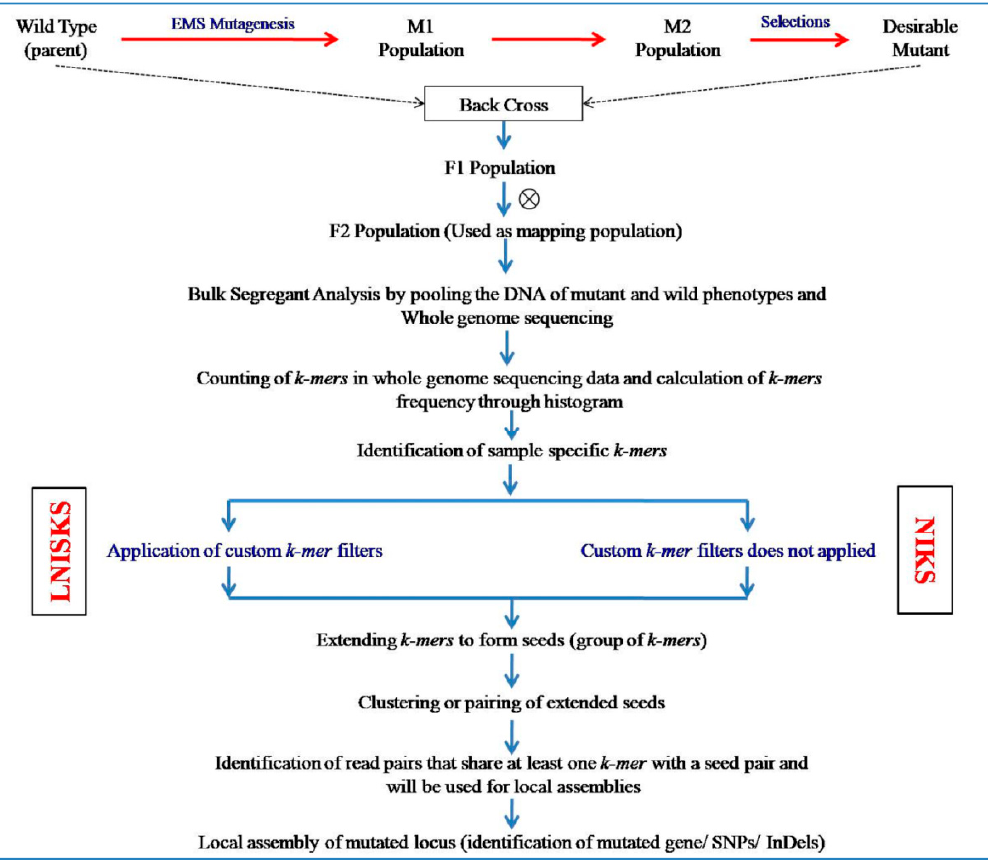
Figure 6. Flow diagram showing the major steps of reference genome independent approaches, needle in the k-stack (NIKS), and longer needle in a scanter k-stack (LNISKS).